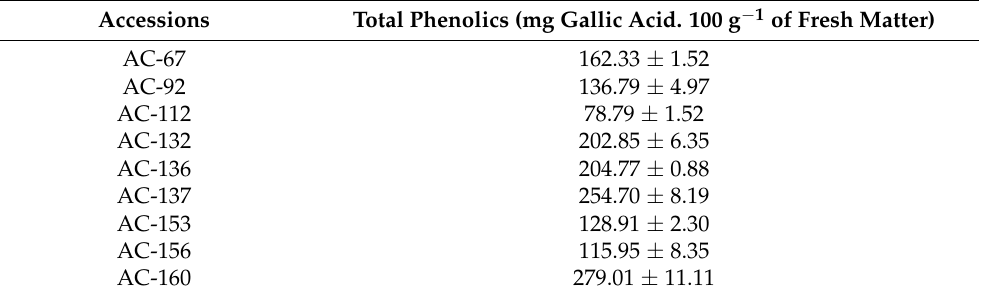
Table 3. Mean values and standard deviation of values of total phenolic compounds in different rumberry